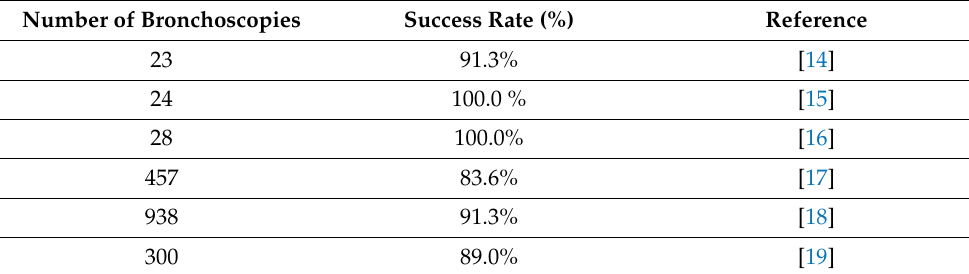
Table 2. Case series of the extraction of FBs using flexible bronchoscope. Number of Bronchoscopies Success Rate